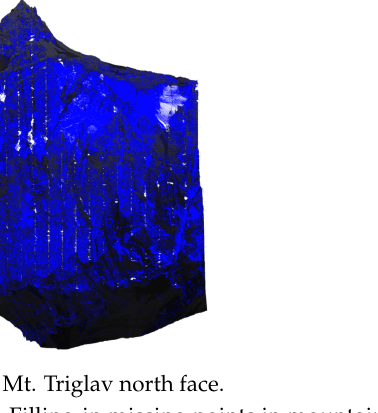
Figure 11. Filling-in missing points in mountain overhangs, where blue are the points added by the presented algorithm and black are the original points from the LiDAR dataset.